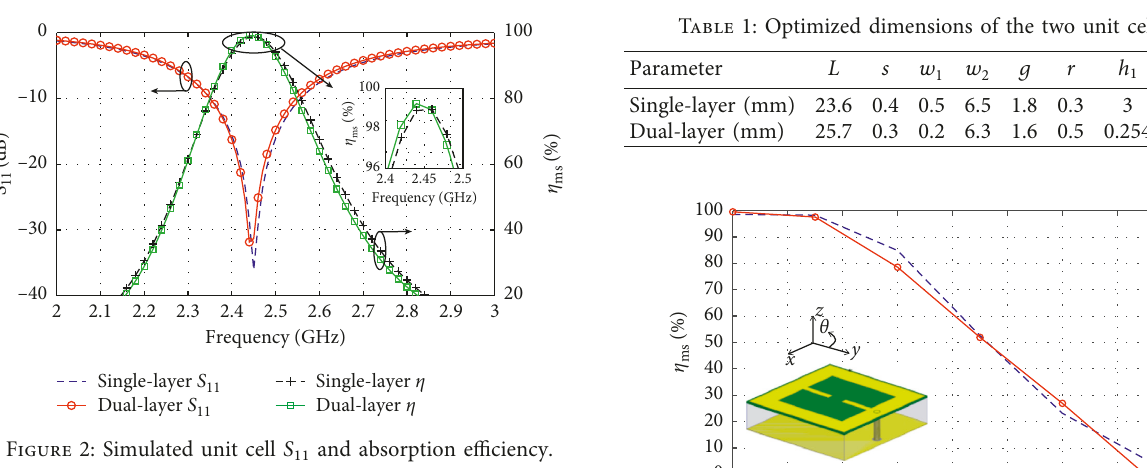
11 and absorption efficiency.